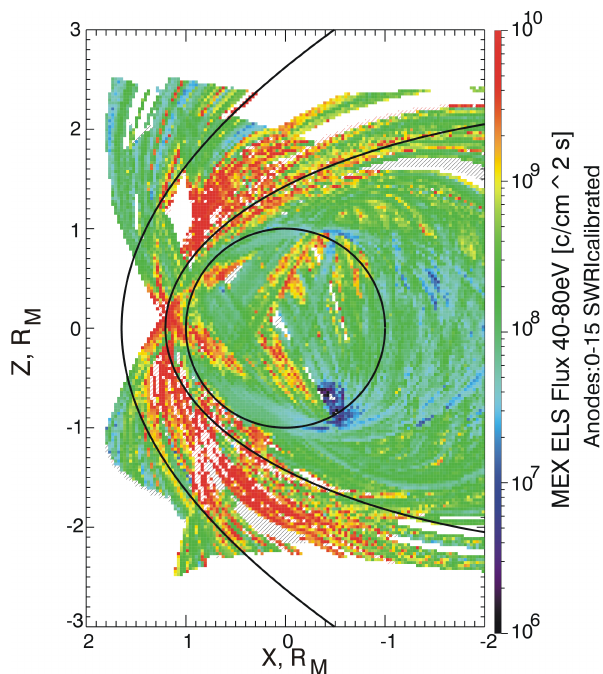
Fig. 9. Map of median electron fluxes (40eV <E< 80eV) in the XZ (MSO) noon-midnight